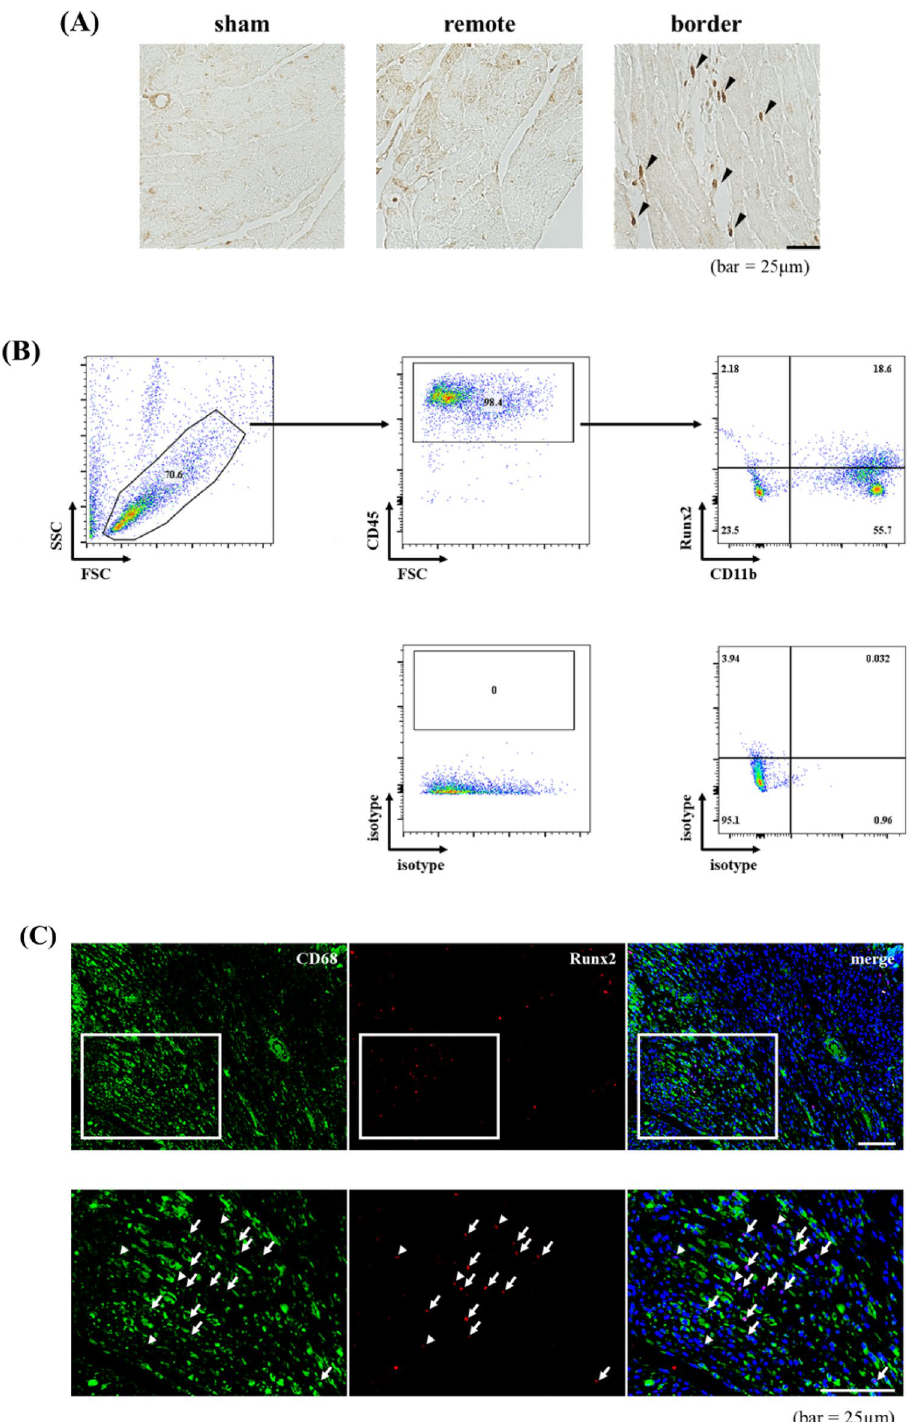
Figure 2. Runx2 was expressed in heart-infiltrating myeloid cells. ( A ) Paraffin-embedded sections of infarcted myocardium were prepared from the heart 7 days after MI. The sections were stained with anti- Runx2 antibody. Representative images are shown. (bar = 25 μm). ( B ) Representative flow cytometry plot of leukocytes enriched from MI7d hearts. ( C ) Frozen sections were prepared from the hearts 7 days after MI. The sections were co-stained with anti-Runx2 and anti-CD68 antibodies. Representative images are shown. Arrows, Runx2 + CD68 + cells: arrow heads, Runx2 + CD68 - cells. (bar = 50 μm). ( D and E ) Flow cytometry analysis of Runx2 expression on F4/80 + CD86 + M1 macrophages (upper) and F4/80 + CD206 + M2 macrophages (lower). CD11b + myeloid cells were enriched from MI4d ( D ) or MI7d ( E ) hearts. Isotype control antibodies were used for positive/negative gate